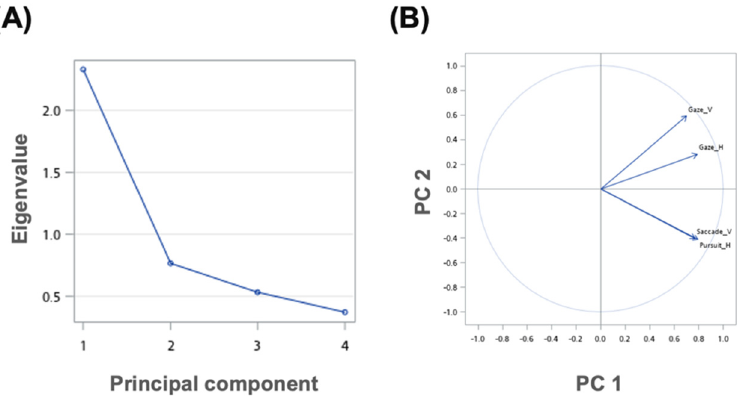
Figure 2. Principal component analysis of oculomotor tests. ( A ) The scree plot shows that the anchor of the graph where the eigenvalues appear to level off lies in PC2. ( B ) The biplot shows the projections of the oculomotor tests on PC1 and PC2 with the four significantly predictive dimensions. PC = principal component. Table 5. Univariate analysis of oculomotor signals predicting abnormal brain MRI. The “factor score” was calculated via principal component analysis of significantly predictive tests ( n = 103).